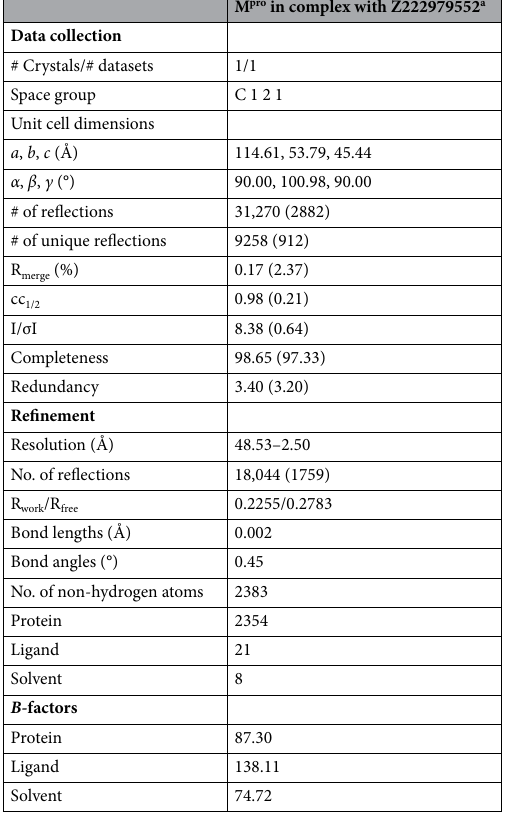
Table 1. X-ray diffraction data and phasing and refinement statistics. a Values in parentheses are for the highest resolution